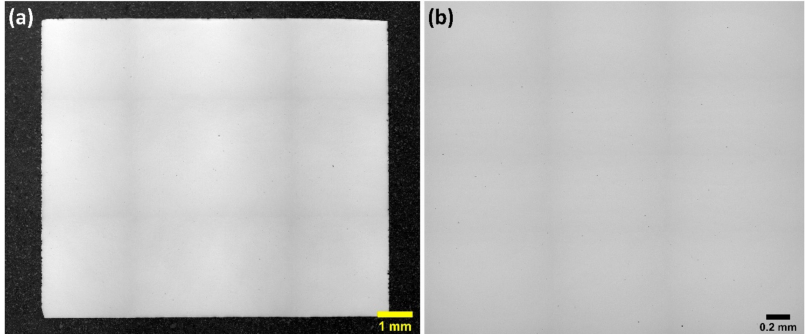
Figure A3. The optical micrographs of the as-built MAD542 processed by #3 printing parameters (laser power: 100 w; scan speed: 1300 mm / s; hatching distance: 50 µ m; layer thickness: 20 µ m). ( a ) The overview of the as-built cube and ( b ) the enlarged view with higher magnification (sample preparation: metallographic polishing).